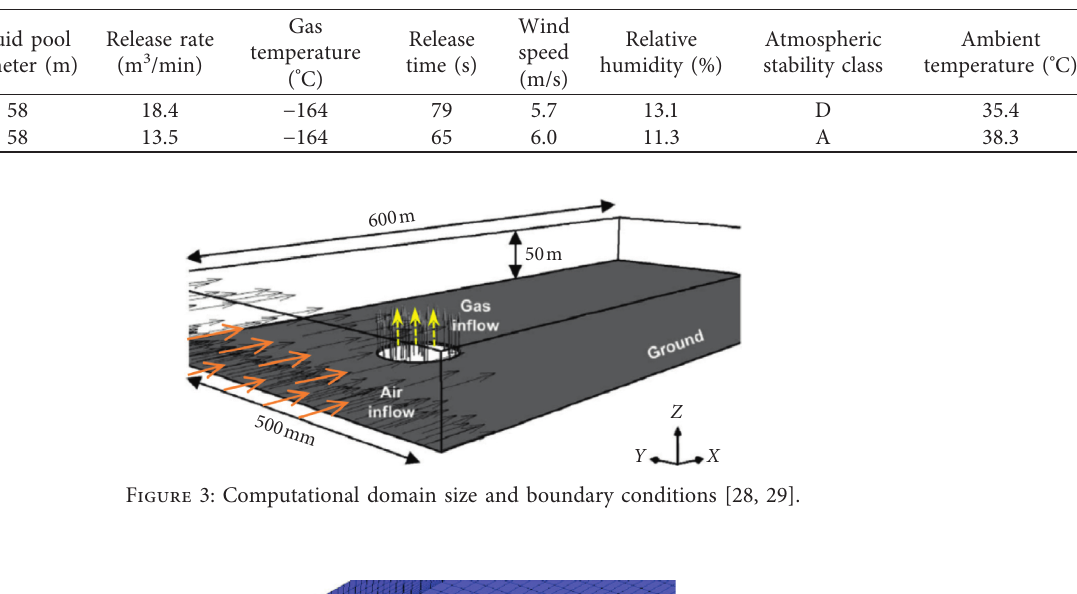
Table 2: Weather and release conditions in Burro/Coyote series trials [28, 29].